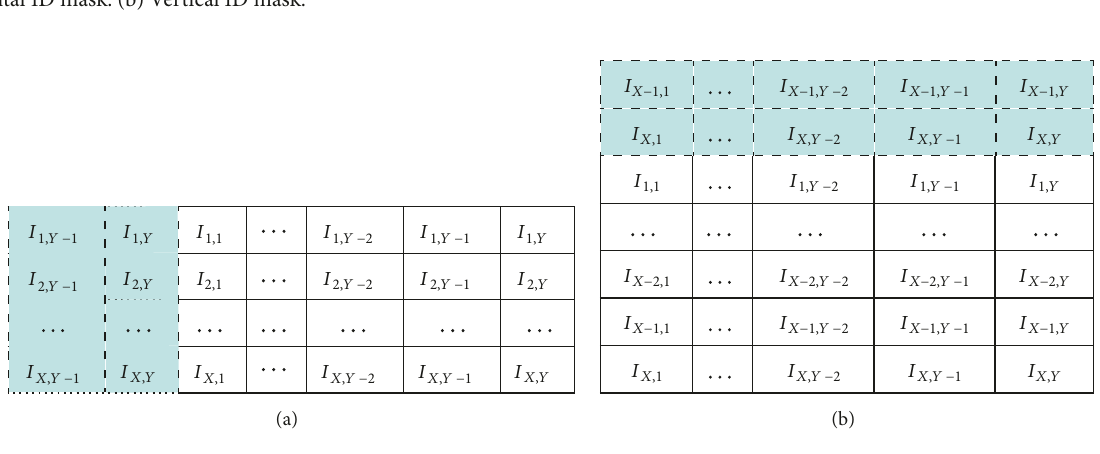
Figure 3: The horizontal and vertical masks are deduced from the original ones with size 2𝑀 + 1 to the simplified ones with size 𝑀 + 1 . (a) Horizontal 1D mask. (b) Vertical 1D mask.